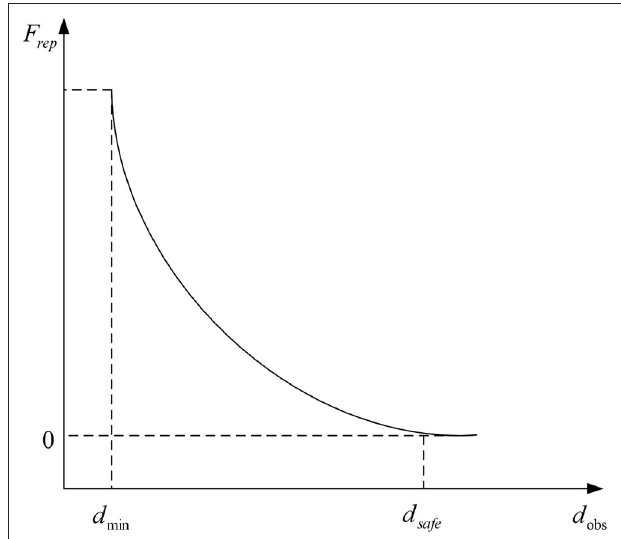
FIGURE 10 | Variation curve of virtual repulsive force with